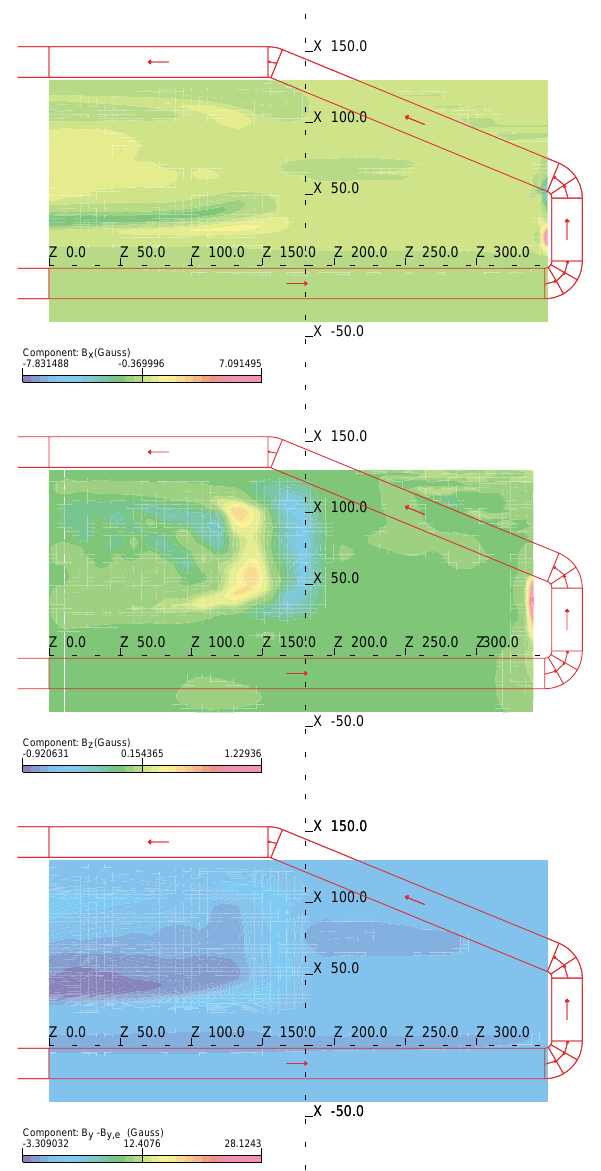
FIG. 5. (Color) Field components B x , B z , and B y 2 B y , e in the midplane of a 90 ± HDSM bending magnet with surface correc- tion coils to compensate field errors due to a slightly misaligned upper yoke.